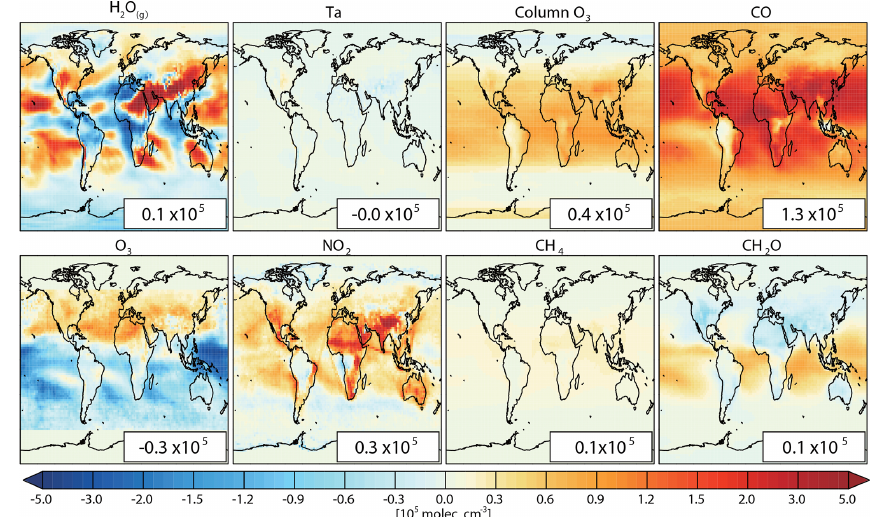
Figure 3. Spatial distributions of the contribution of individual factors to the difference between CESM1–CAM4Chem simulated and observation-based (modeled–observation-based) [OH] trop-M . The global mean values are shown inset in molec.cm − 3